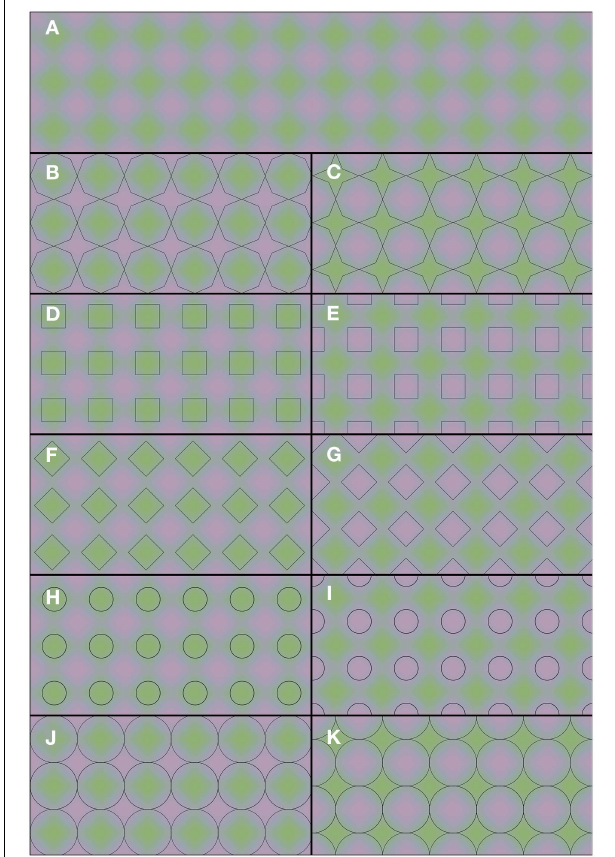
FIGURE 2 | Flexible color averaging between outlines. Again, the underlying colored image is the same for each panel. In fact, the total figure is one regular purple-green plaid (as seen in A ) on which the horizontal and vertical panel dividers and the black outlines within each of ( B–K ) have been superimposed.